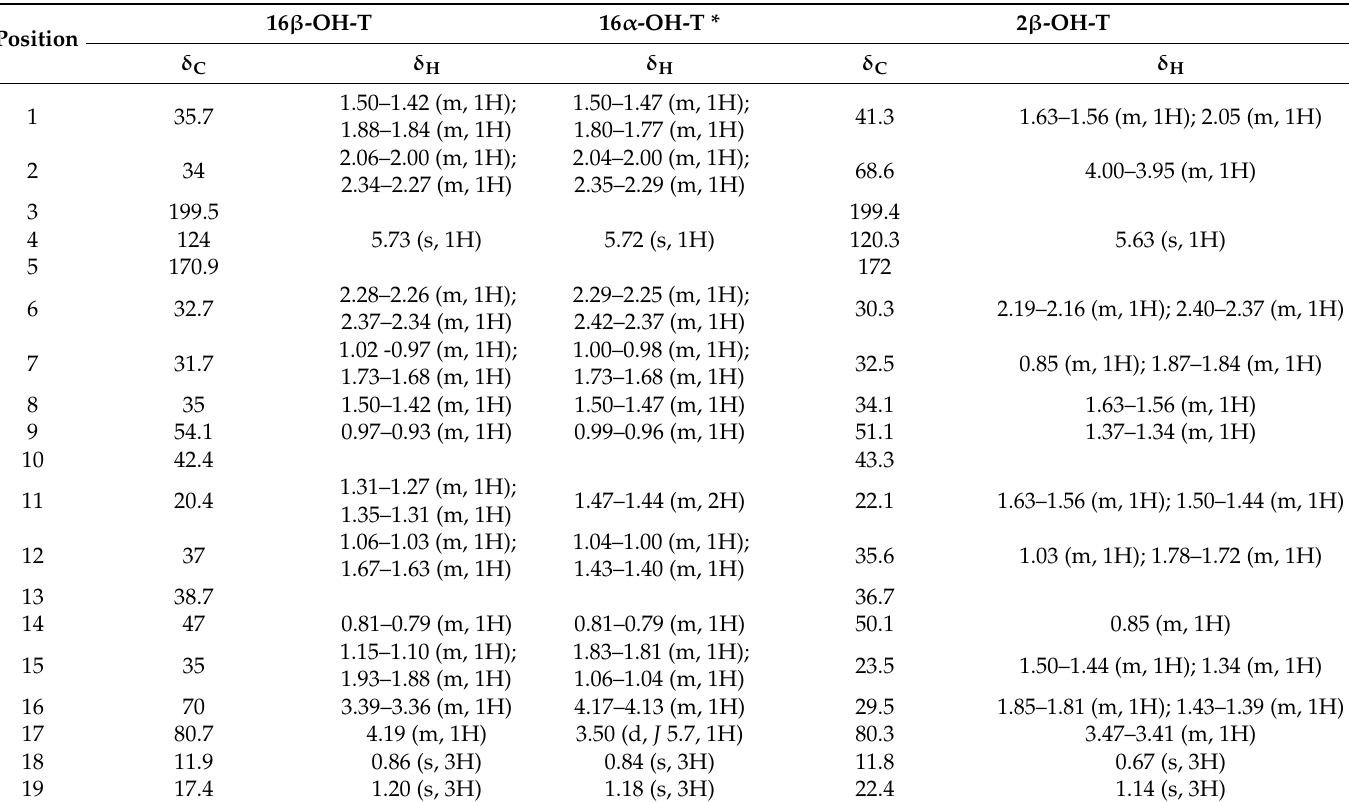
Table 1. 1 H and 13 C-NMR data for 16 β -OH-T, 16 α -OH-T and 2 β -OH-T (600 MHz for 1 H-NMR and 150 MHz for 13 C-NMR, D 2 O, δ in